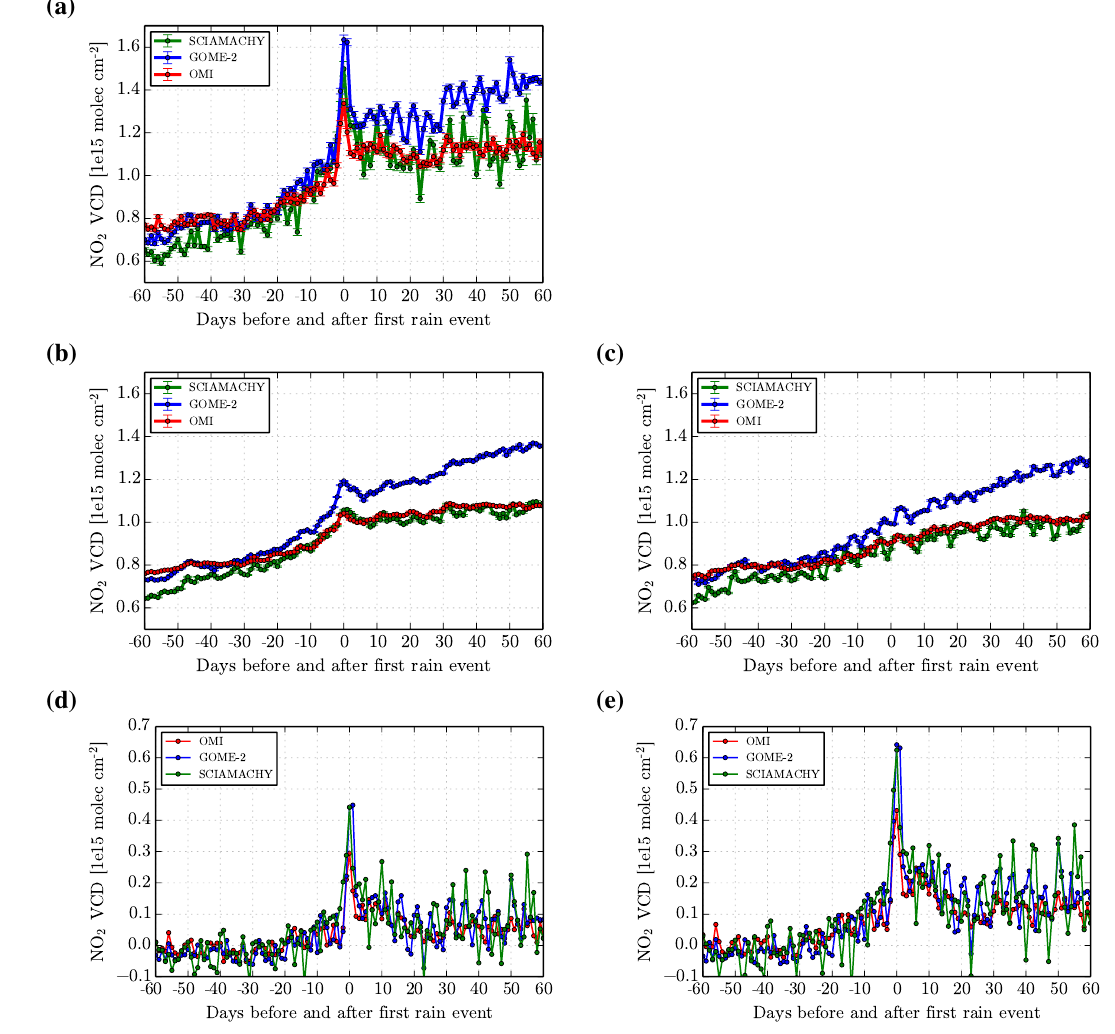
Figure 12. Analysis of NO 2 VCDs 60 days before and after the first day of rainfall in the April–May–June period for the Sahel region. (a) NO 2 VCDs from OMI, GOME-2 and SCIAMACHY. (b) Latitudinal averaged NO 2 VCDs corresponding to the reference (for details see text). (c) Latitudinal-averaged NO 2 VCDs corresponding to the reference considering an additional buffer of 10 pixels around the actual-triggered pixel to avoid influence of enhanced NO 2 VCDs in the vicinity of the precipitation events. (d) Background corrected NO 2 VCDs: (a – b) . (e) Background (with buffer) corrected NO 2 VCDs: (a – c)